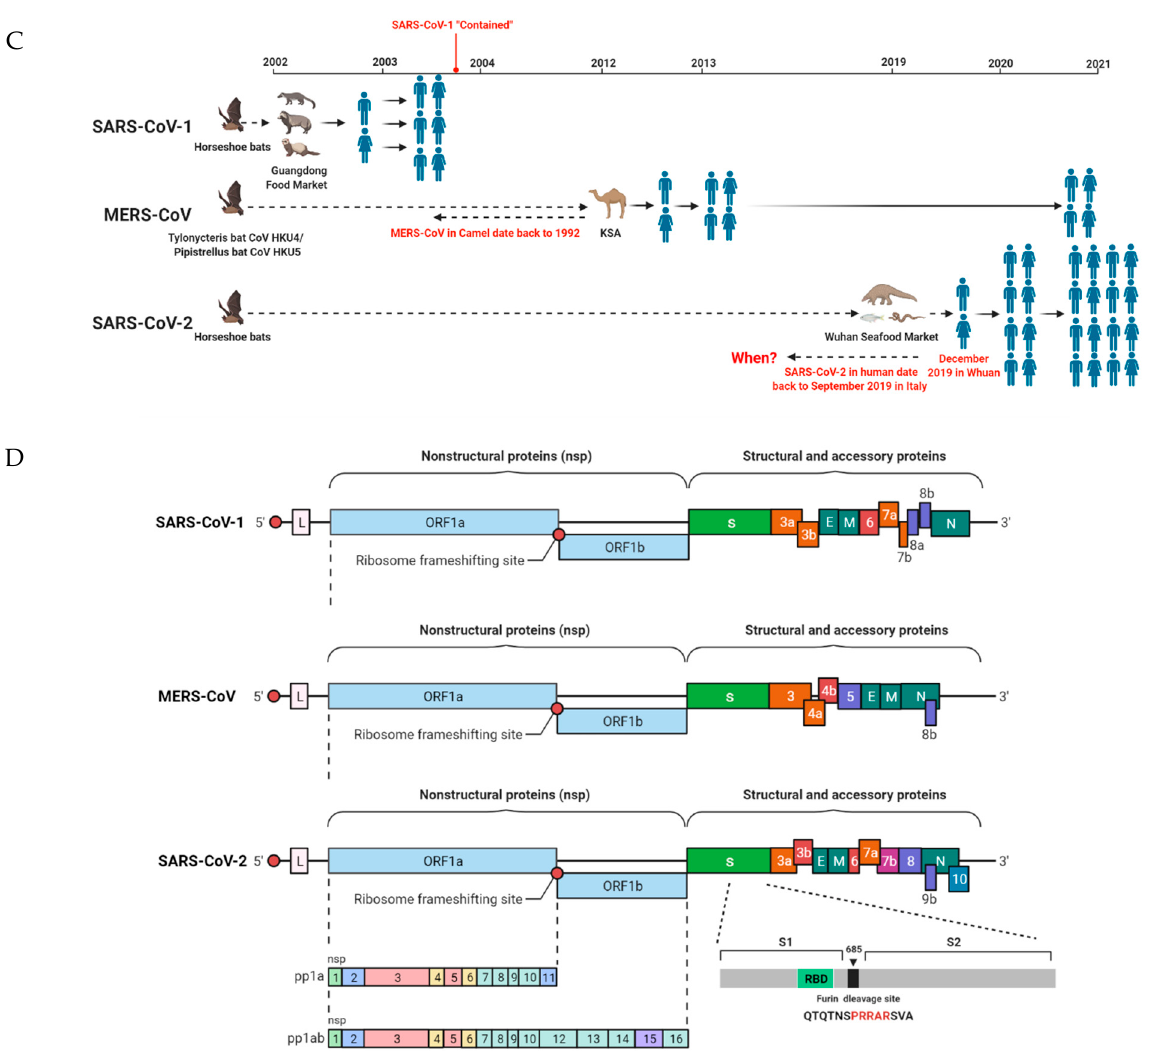
Figure 2. Coronavirus particle, genomes, related family tree and identities of non-structural proteins. The structure of the coronavirus virion ( A ), the coronavirus family tree ( B ), genomes of SARS-CoV-1, MERS-CoV and SARS-CoV-2 ( C ) and timelines for emergence of SARS-CoV-1, MERS-CoV and SARS-CoV-2 ( D ) (created with BioRender.com).